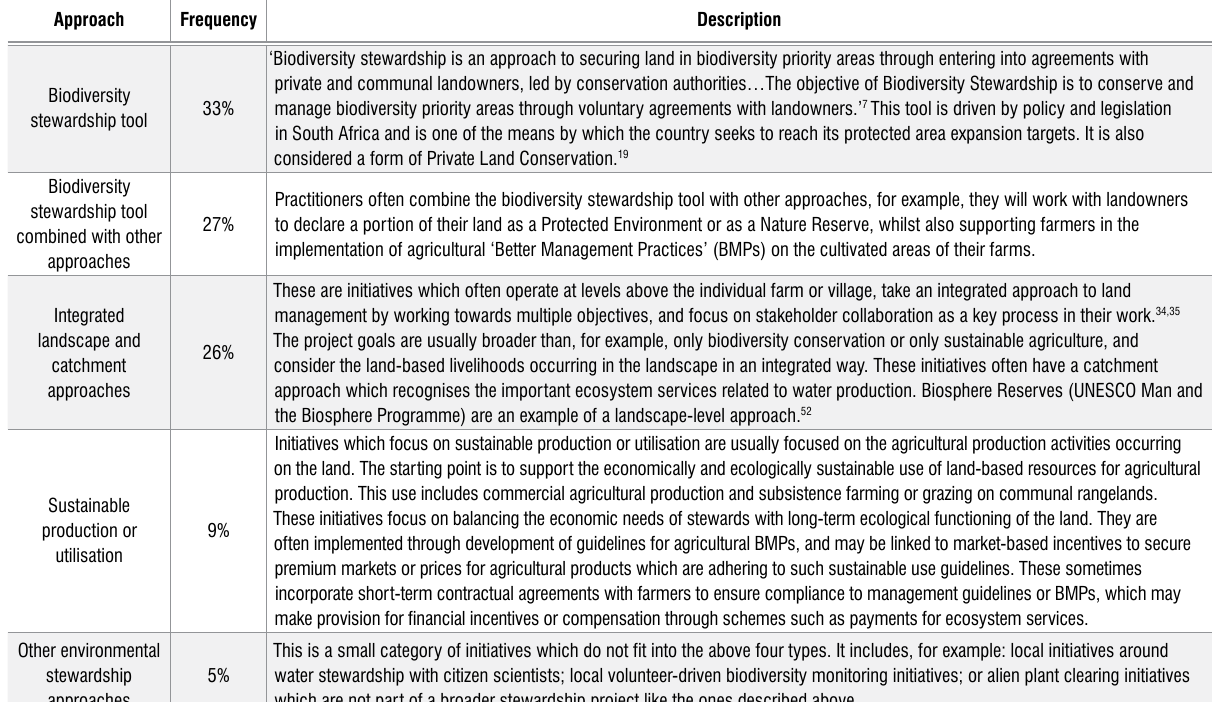
Stewardship approaches or models applied in respondents’ projects ( n =95) Approach